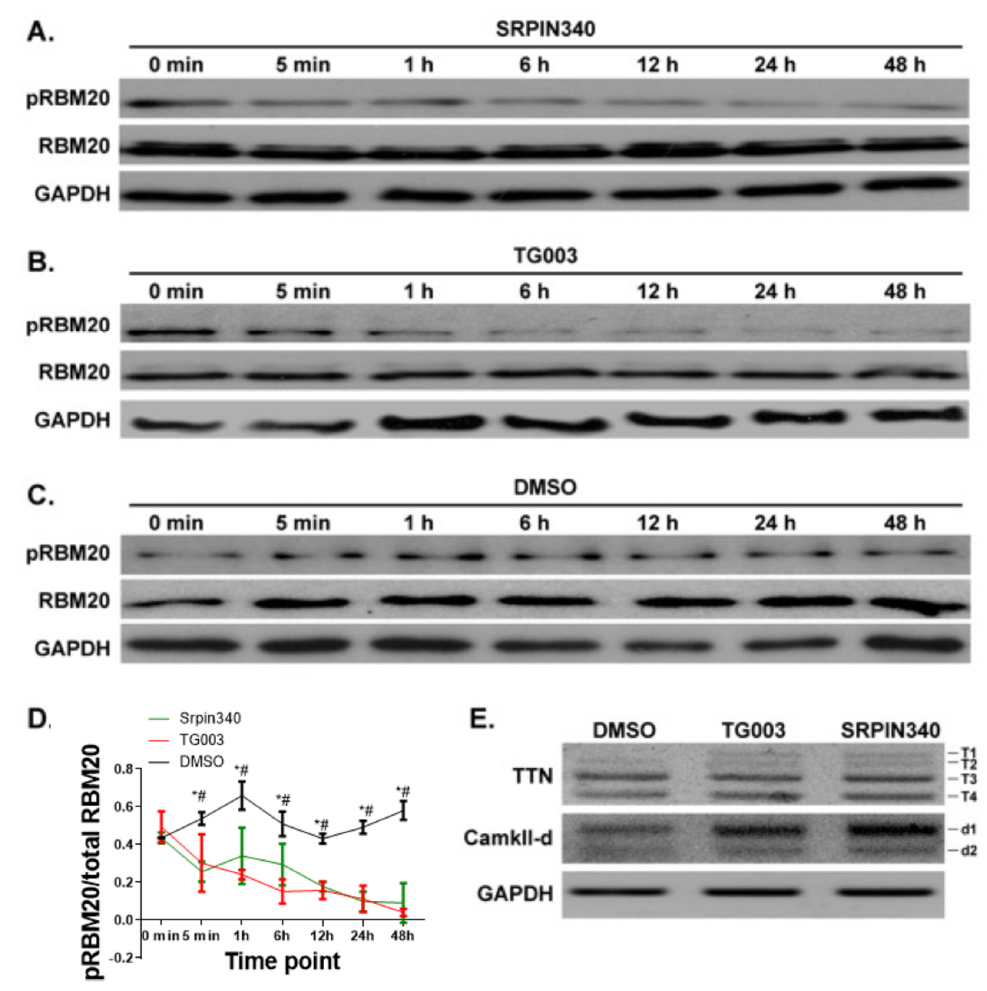
Figure 4. Impact of the inhibition of SRPK1 and CLK1 on RBM20 RSRSP stretch phosphorylation and target pre-mRNA splicing in vivo. ( A – C ) Western blot analysis of phospho- and pan-RBM20 in NRCMs treated with vehicle (DMSO), SRPIN340, or TG003 at different time points. ( D ) Quantification of Western blot results from ( A – C ). ( E ) RT-PCR analysis of Ttn and Camk2d splice variant expression in vehicle- or inhibitor-treated NRCMs. Ttn variants, T1–T4; Camk2d variants, d1 and d2. GAPDH served as a loading control for Western blot and housekeeping gene for normalization of RT-PCR data. Graph shows mean ± SD ( n = 3); * p < 0.05 compared between SRPIN340 and DMSO, and # p < 0.05 compared between TG003 and